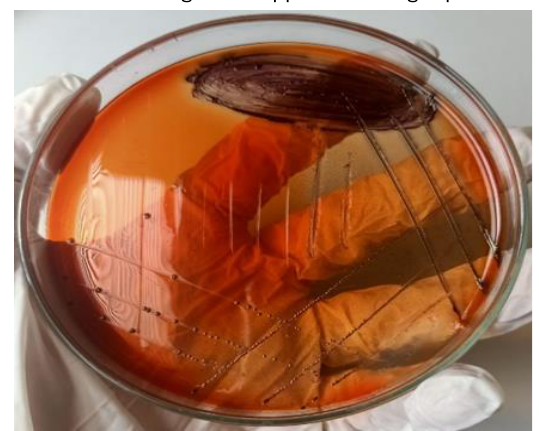
Figure 1. Black colonies of biofilm producing E. coli isolates Congo red supplemented agar plate.